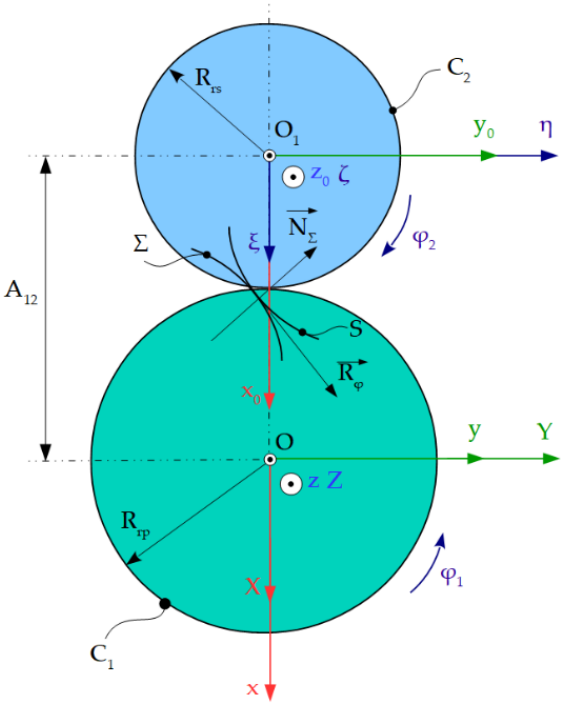
Figure 8. Generating with gear shaped cutter tool.